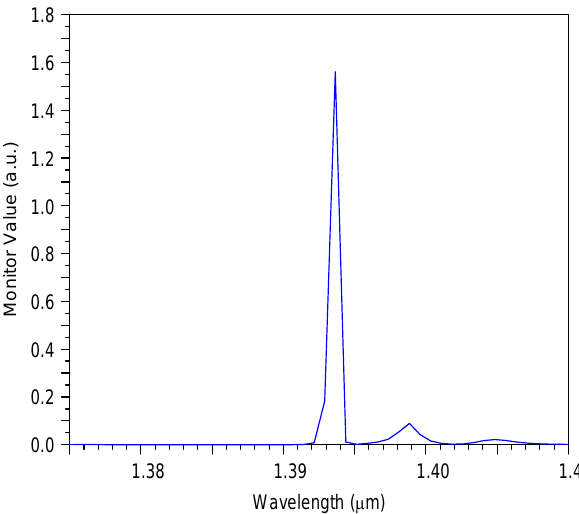
Fig.3. The output transmission spectra of the nano-ring resonator. The resonant peak wavelength gets at 1393.6 nm and the quality factor reveals about 1700.